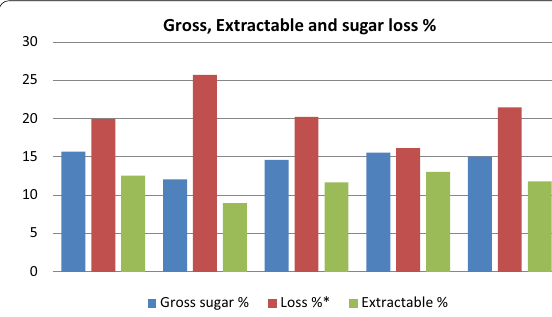
Fig. 2 Effect of different weed control treatments on gross and extractable sugar yield fed − 1